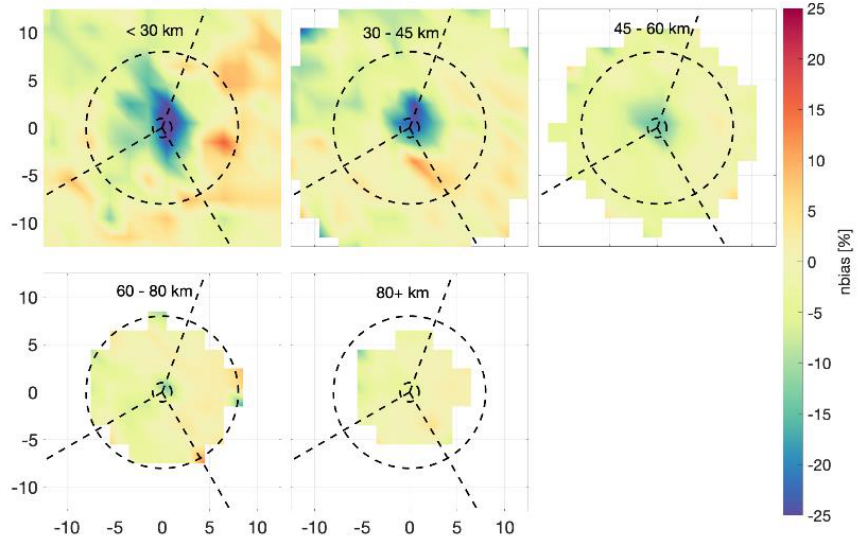
Figure 17. As in Figure 13, each subplot parsed by radius of maximum winds.